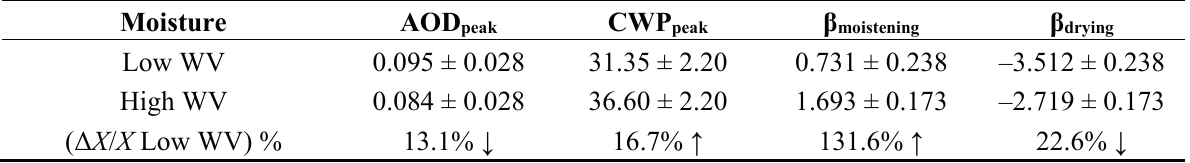
Figure 11. Response of cloud water path (CWP) to increasing aerosol optical depth (AOD) in low and high atmospheric water vapor (WV) environments for AADR_SubTrop. Table 5. Percent increase ( ↑ ) or decrease ( ↓ ) in the characteristic parameters of cloud water path (CWP) response curve to increasing aerosol optical depth (AOD) for low and high atmospheric water vapor (WV) environments for AADR_SubTrop. The maximum and minimum changes are, respectively, observed for β moistening and AOD peak